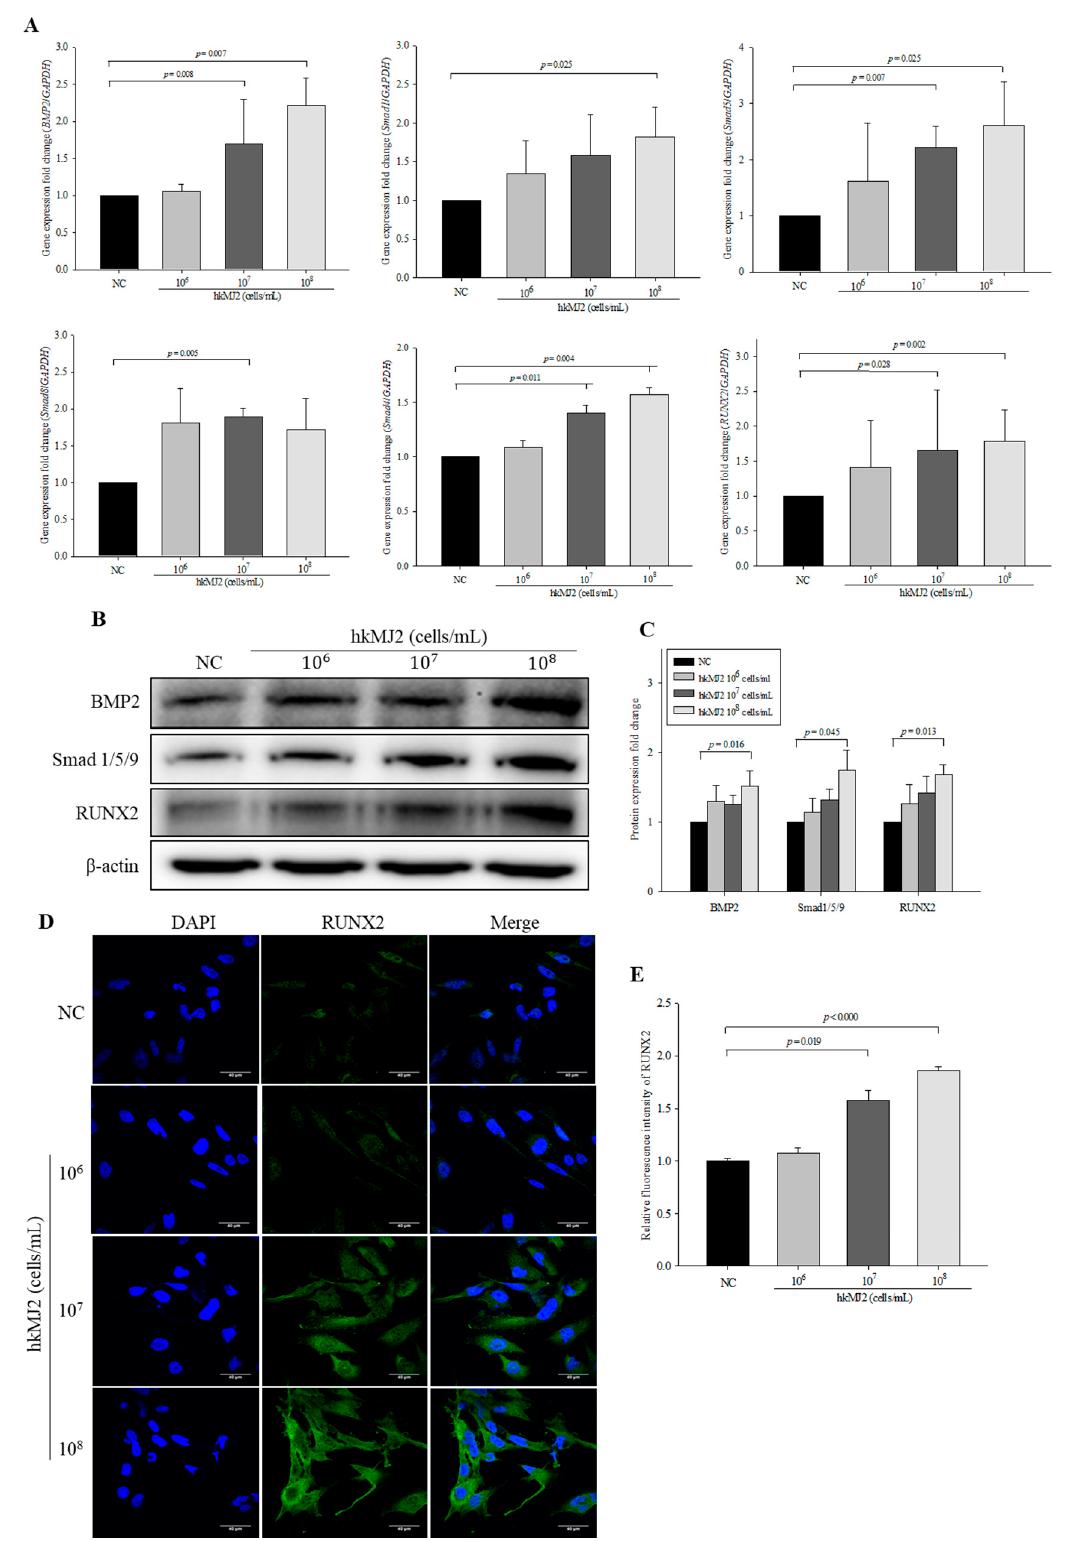
Figure 5. Effect of heat-killed P. freudenreichii MJ2 (hkMJ2) on the expression levels of BMP2/RUNX2 signaling-related genes and proteins. The expression levels of genes were measured by qPCR ( A ) and proteins were measured by Western blotting ( B ) and quantified ( C ). The expression level of RUNX2 protein was measured by immunocytochemistry (ICC) ( × 60, scale bar = 40 µ m) ( D ) and the relative intensity was quantified ( E ). The values indicate the mean ± SD of three independent experiments performed in